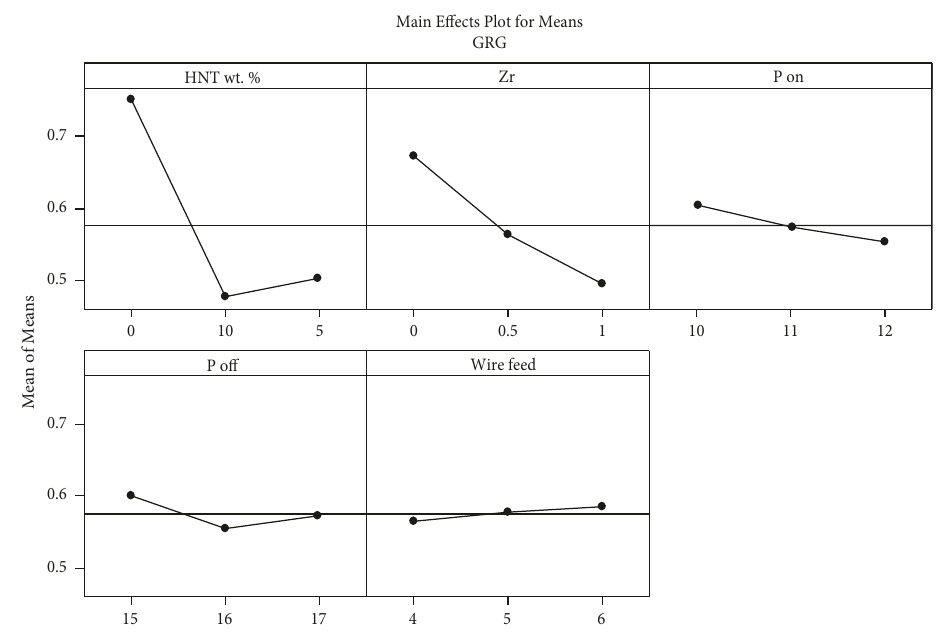
Figure 9: Main effects plot of the mean of means on Table 8: Analysis of variance for GRG.